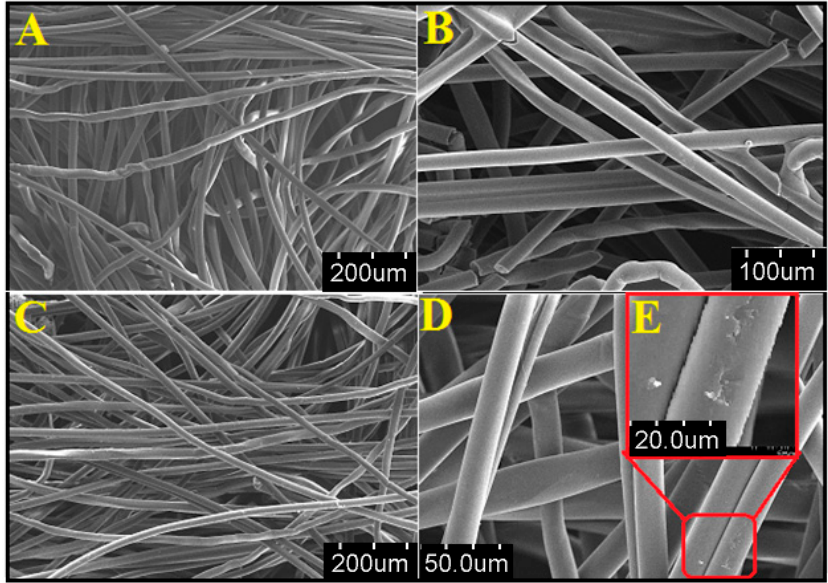
Figure 2. FESEM images of ( A , B ) nascent cellulose nanofibers at the varying resolution, ( C , D ) surface-modified cellulose nanofibers at the varying resolution, ( E ) inset of figure ( D ) showing surface roughness after chemical modification.